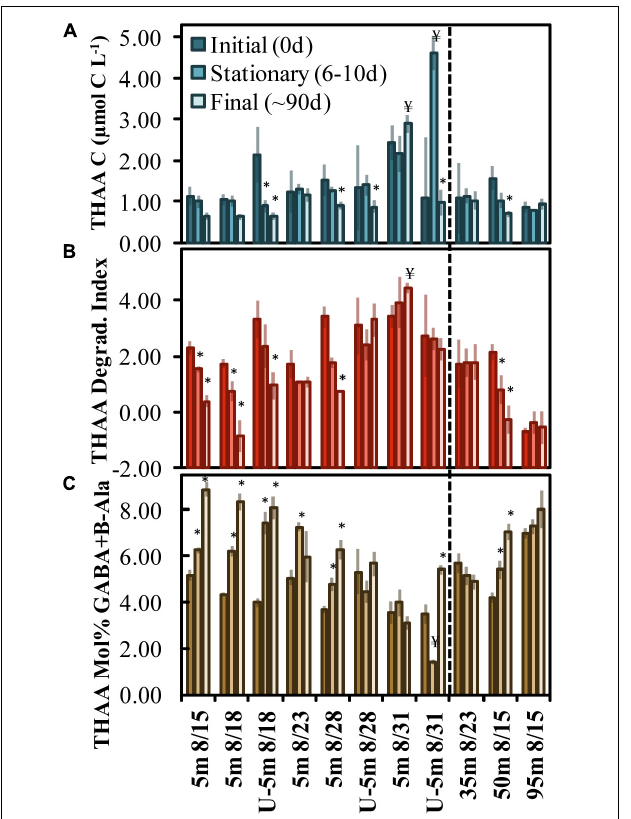
FIGURE 2 | OM remineralization experiment changes in total hydrolyzable amino acid (THAA) C (A) , the degradation index score (B), and mol% GABA + B-Ala (C) between initial (0 day), stationary phase (6–10 days) and final time points ( ∼ 90 days). The x -axis indicates the experiment initiation date and those beginning with a “U” refer to undiluted experiments (all others are 70% dilutions). The * and (cid:85) above the bars identify treatments that exhibited a statistically significant (two-tailed t -test p < 0.05) shift to a more or less diagenetically altered OM composition, respectively. Error bars refer to propagated standard errors. Dashed vertical line differentiates surface from subsurface experiments.